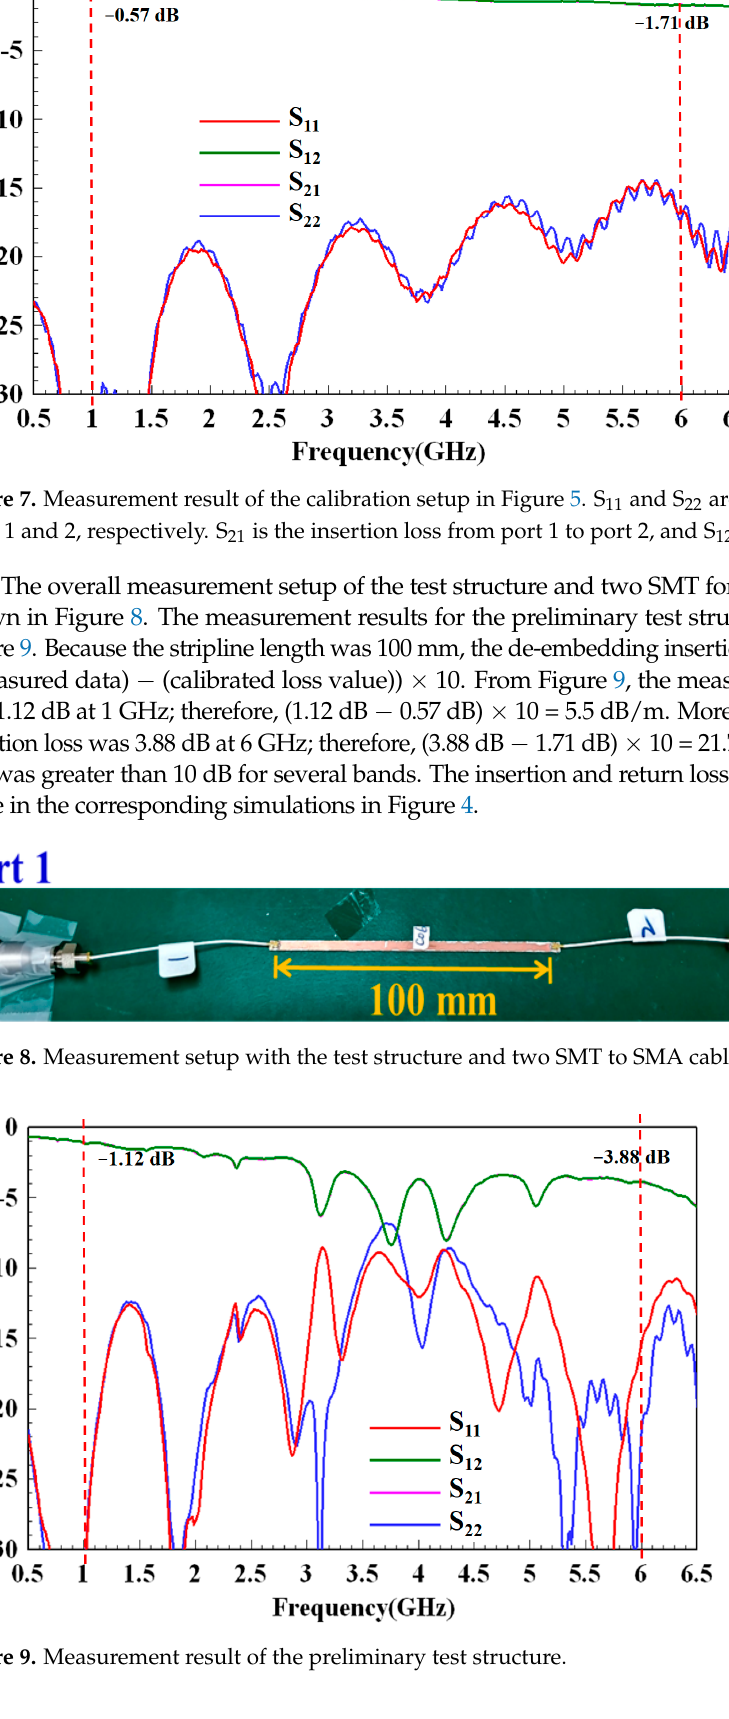
Figure 10. PTFE layers are not properly laminated without a bonding layer. 4. Simulations of the Modified Designs Several simulations were performed to further explore the designs and optimal solu- tions. 4.1. Vias vs. Ground Line In the previous section, parallel ground lines were designed to confine the EM field and reduce radiation loss. However, the two parallel ground lines caused the entire stripline to become less flexible. The new stripline structure with vias is shown in Figure 11. The vias were utilized to connect the top and bottom ground metal layers to maintain good ground conduction. The radius of the vias was 0.5 mm. The via placement was asym- metric along the stripline edges. As observed, asymmetric via placement was more flexi- ble than symmetric via placement. The distance between two vias along the same edge was 5 mm. The simulation results for the parallel ground lines and vias are shown in Fig- ure 12, according to which the return losses were all <20 dB in the two scenarios. The insertion loss of the parallel ground line scenario was 2.28 dB at 1 GHz and 6.29 dB at 6 GHz. The insertion loss of the asymmetric via placement scenario was 2.33 dB at 1 GHz and 6.40 dB at 6 GHz. From the simulations, the characteristics of the two scenarios were found to be similar. Thus, the use of asymmetric via placement is feasible.